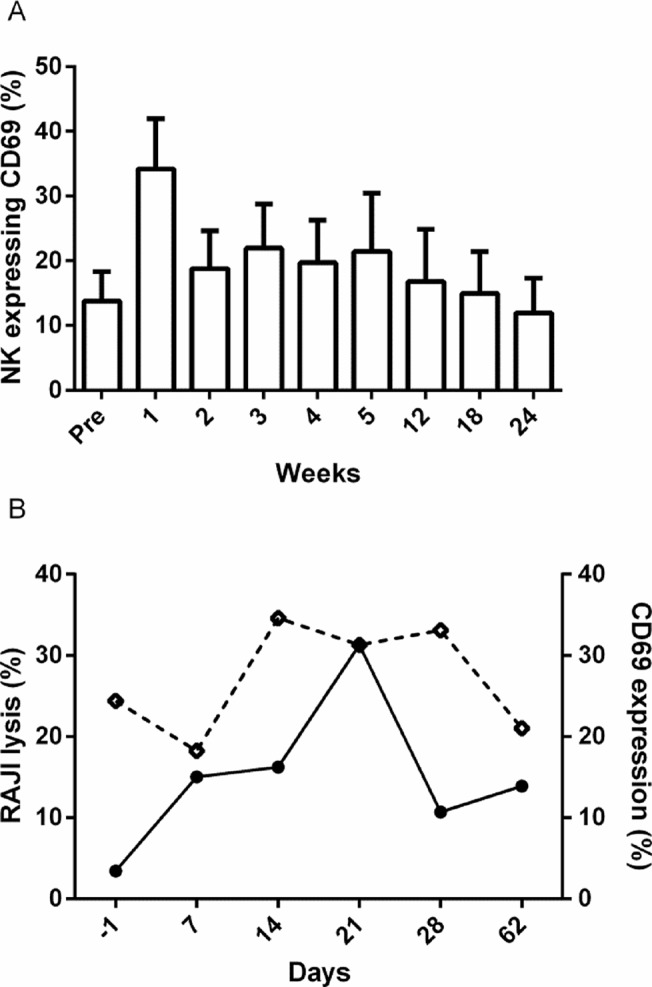
Presence of activated NK cells in peripheral blood.All patients were monitored for the proportions of resting and activated NK cells in their peripheral blood prior to and post primed allogeneic NK cell infusion. NK cell activation in peripheral blood increased within the first two weeks of infusion and did not return to pre-infusion levels until week 12 (A—data shown are mean +/- SD n = 7). A single patient (01) was consistently monitored for the presence of activated NK cells in her peripheral blood which lysed NK-resistant Raji cells in vitro at a fixed effector:target ratio of 5:1 (B—closed circles). The presence of functional primed NK cells closely mirrored the presence of CD69+ NK cells (B—open squares).